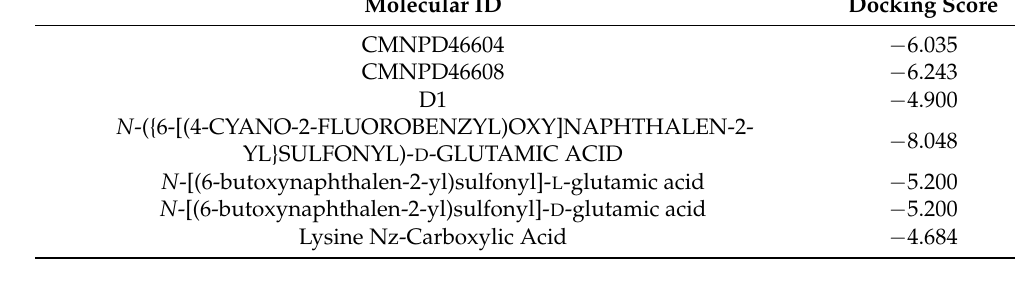
Table 3. The docking fraction of compound 46604 and 46608 with the inhibitor.